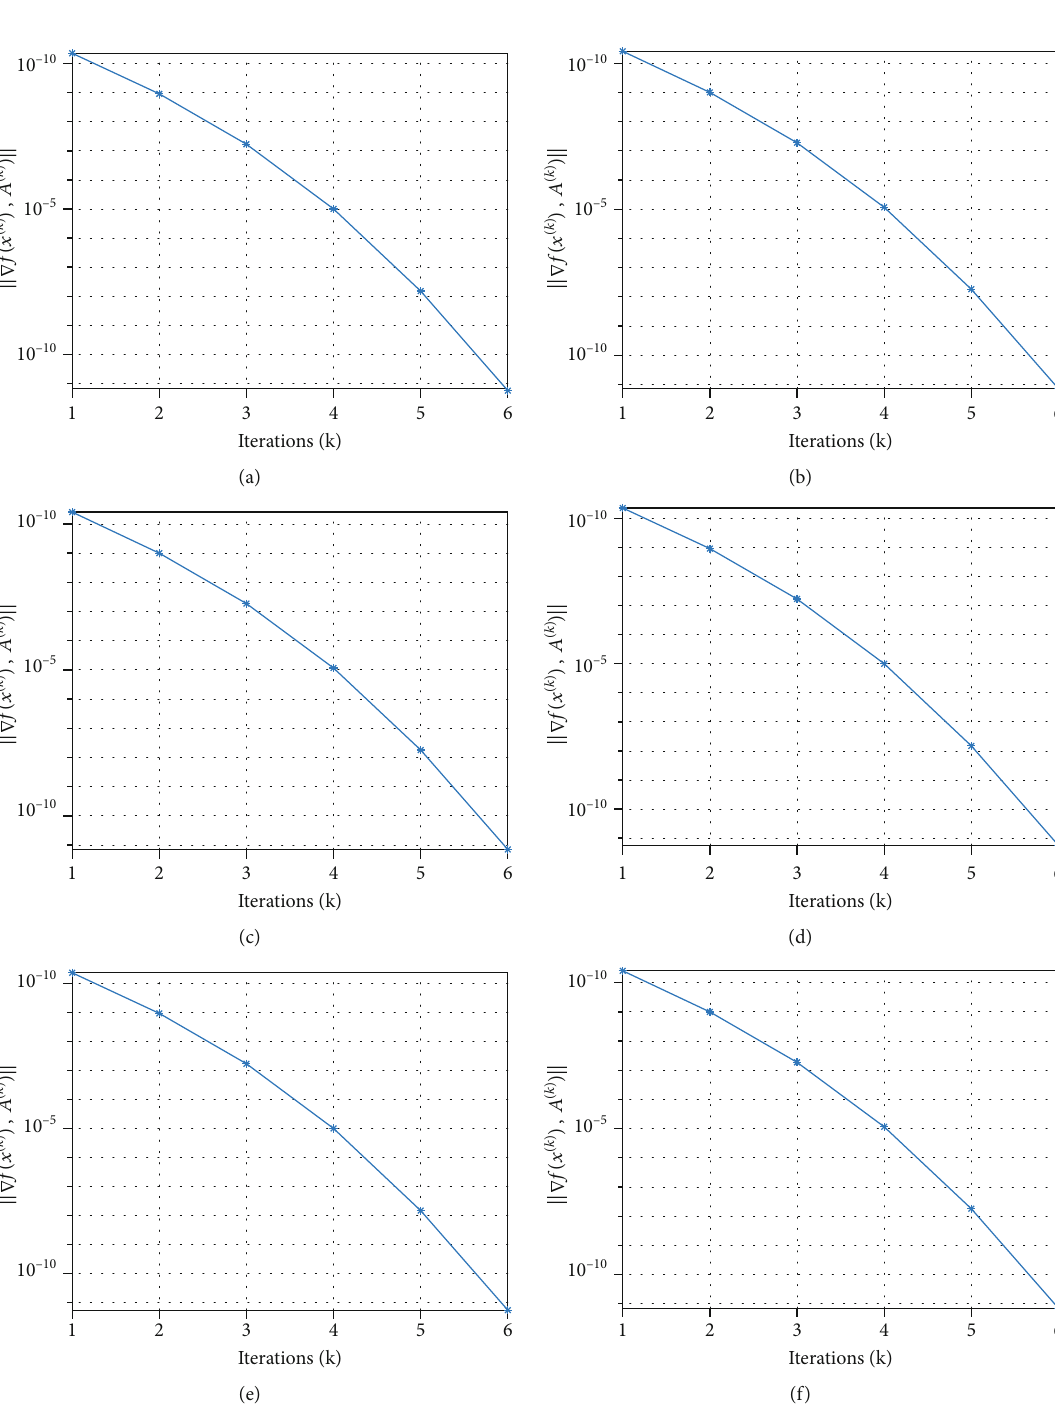
Figure 1: Diagrams of error k ∇ f ð x ð k Þ , A ð k Þ Þk versus iterations k of experiment